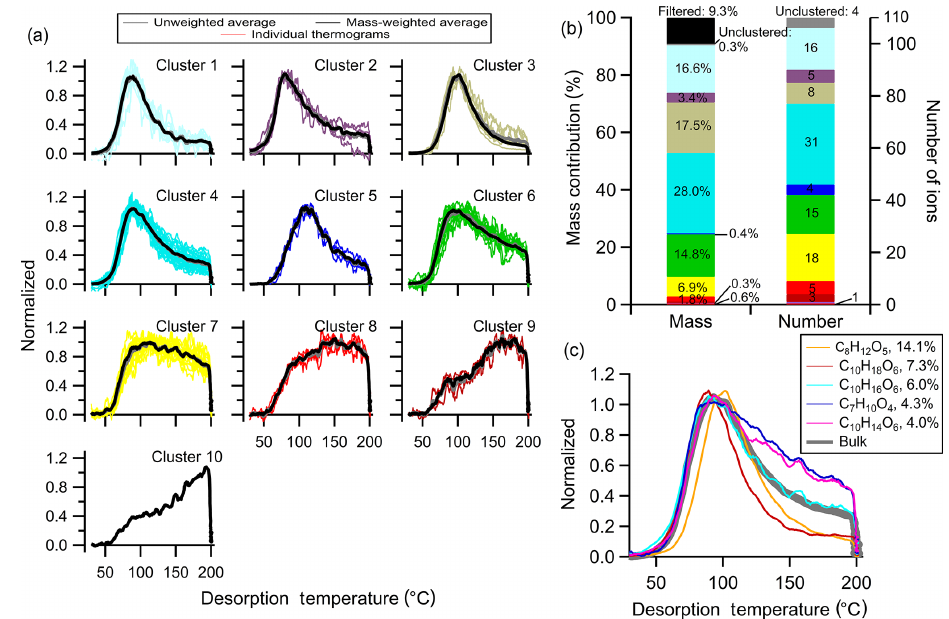
Figure 7. Same as Fig. 5, but for (cid:49) -3-carene + OH SOA. (a) Unweighted average thermograms (bold gray lines), mass-weighted average thermograms (bold black lines), and individual members (colored lines) of the 10 clusters identified. (b) Percentage contribution of each cluster to the total mass, the filtered-out and unclustered mass percentage (left bar), the number of ions in each cluster, and the unclustered number of ions (right bar). (c) Thermograms of the top five ions in terms of mass contribution. The cluster colors are consistent between (a) and (b)